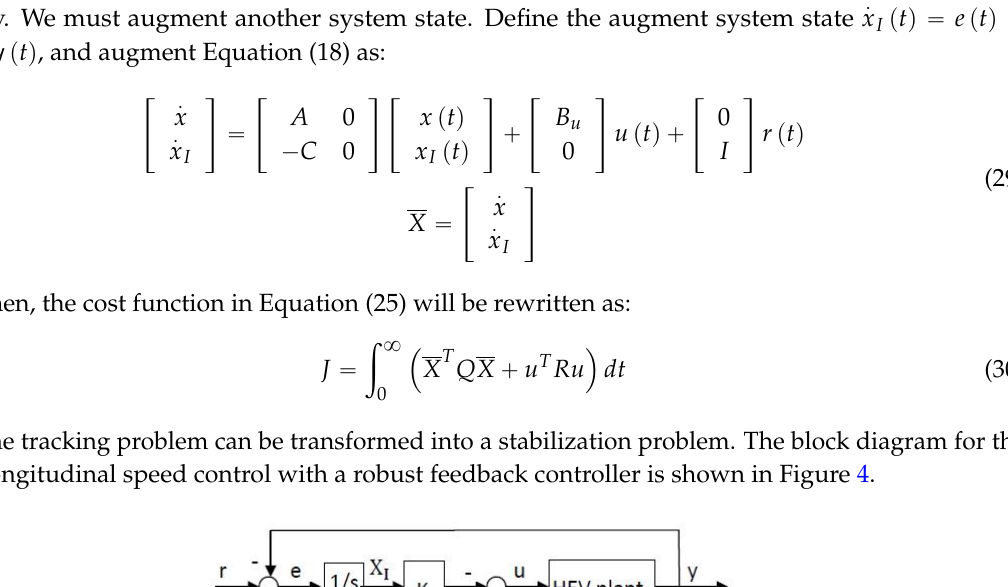
Figure 5. Block diagram for the HEV longitudinal speed control with forward compensator. Note that the tracking error includes the output of the integrator and the state feedback components. Thus, this type of 2-DoF approach has the potential to enhance the performance problems identified in the original implementation. The entire design process of the forward controller ( 𝐹 𝐶 ) is described as follows. Assume the state X of the HEV system in Figure 4 can be partitioned into 𝑥 and 𝑥̌ . 𝑥 are the parts we care about for tracking ( 𝑇𝑋 ) that we assume are directly available from 𝑦 = 𝑥 = 𝐶𝑋 , and x̌ are the parts we do not care about for tracking ( 𝑥̌ = 𝑇̅𝑋 ). The matrices of 𝑇 and 𝑇̅ can be considered selectors with diagonals of one and zero, but they do not always take this form. Assume 𝑇̅ is the complementary matrix of 𝑇 (𝑇 + 𝑇̅ = 𝐼) and state (vehicle speed) x is part of state vector 𝑋([𝑥, 𝑣, … ] 𝑇 ) ; let 𝑒 = 𝑟 − 𝐶𝑋 , the control input 𝑢 in Equation (31) is rewritten as: 𝑢 = −𝐾(𝑥̌ − 𝐹𝑐 × 𝐶𝑋 + 𝐹𝑐 × 𝑟) − 𝐾 𝐼 𝑋 𝐼